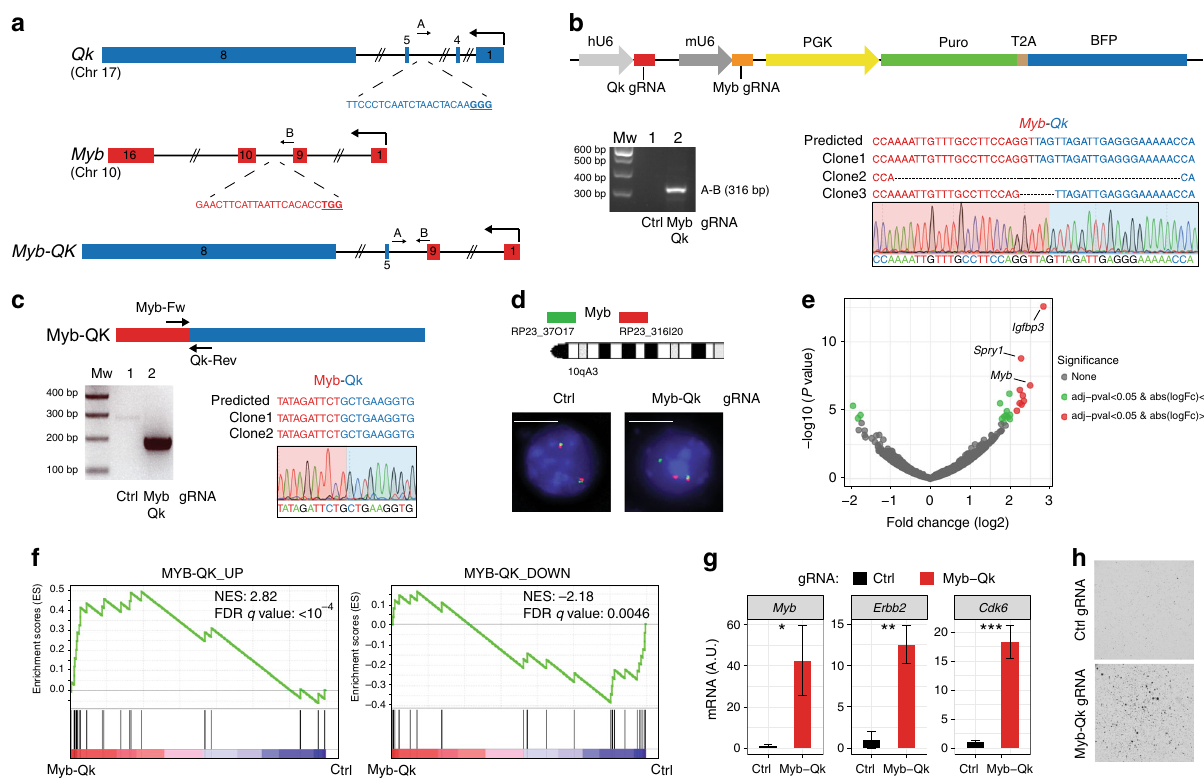
Fig. 6 Generation of the Myb-Qk chromosomal translocation. a Schematic representation of the Myb and Qk gene loci and the Myb-Qk gene fusion. Indicated are the gRNAs targeting both genes and the primers used for the PCR ampli fi cation of the indicated genomic regions. b Top panel: RCAS-gRNA- pair vector expressing the Myb and Qk gRNAs. Bottom panels: PCRs were performed with the speci fi ed primers on genomic DNA extracted from the p53- null TVA-Cas9 NSCs transduced with the indicated gRNAs. The PCR band for the Myb-Qk gRNA infected cells was sub-cloned and analyzed by Sanger sequencing. The sequences of three independent clones and a representative chromatogram are shown. c Top panel: Schematic representation of Myb-Qk fusion transcript. Bottom panels: (left) RT-PCRs were performed on the mRNA from the p53-null TVA-Cas9 NSCs transduced with the indicated gRNAs, using the Myb-Fw and Qk-Rev primers; (right) the PCR band was sub-cloned and the sequences of two independent clones and a representative chromatogram are shown. d Top panel: Diagram of FISH probe design (see Methods for details). Mouse BACs are represented as green and red bars. Bottom panels: Representative FISH results using the break-a-part probe designed to detect the Myb-Qk translocation. Scale bar: 5 μ m. e Volcano plot of differential gene expression in Myb-Qk ( n = 2) versus Ctrl gRNA cells ( n = 2). f GSEA analysis using the published MYB-QK signature genes 47 . NES normalized enrichment score, FDR false discovery rate. g qPCR analysis shows the upregulation of Myb-QK -activated genes in the p53-null TVA-Cas9 NSCs expressing the Myb-Qk fusion. Data presented as mean ± SD ( n = 3); Student ’ s t test: *** P < 0.001, ** P < 0.005, * P < 0.05; A.U. arbitrary unit. h p53-null TVA-Cas9 NSCs transduced with the Myb and Qk gRNAs, but not Ctrl gRNA, are able to growth in soft